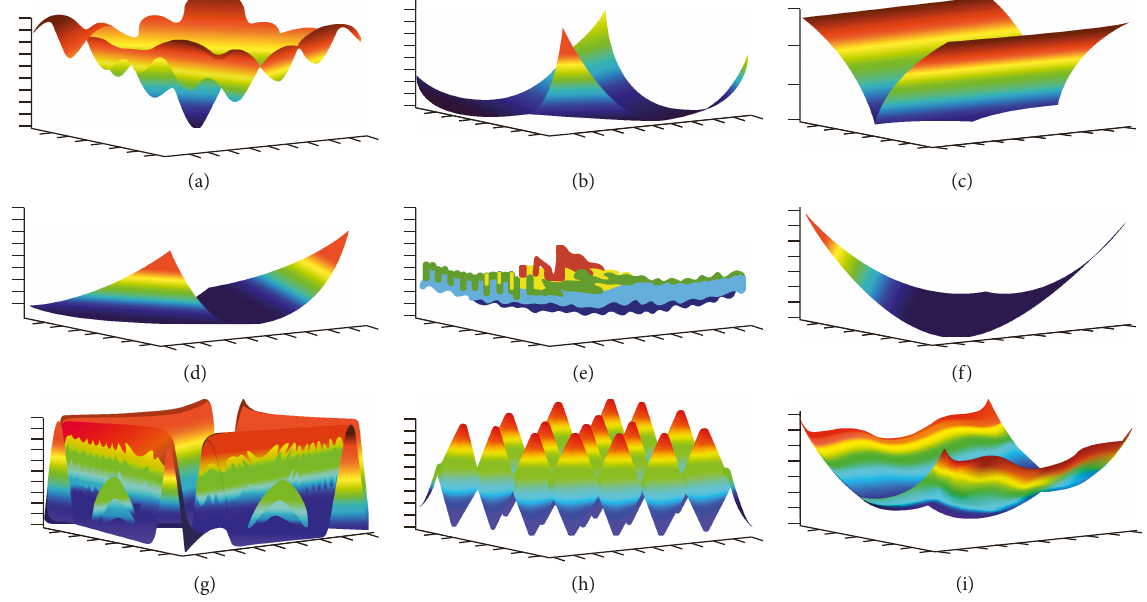
Figure 1: The function benchmarks are (a) Ackley, (b) Beale, (c) Bukin6, (d) Leon, (e) Levi13, (f) Matyas, (g) Modscha ff er2, (h) Rastrigin, and (i)